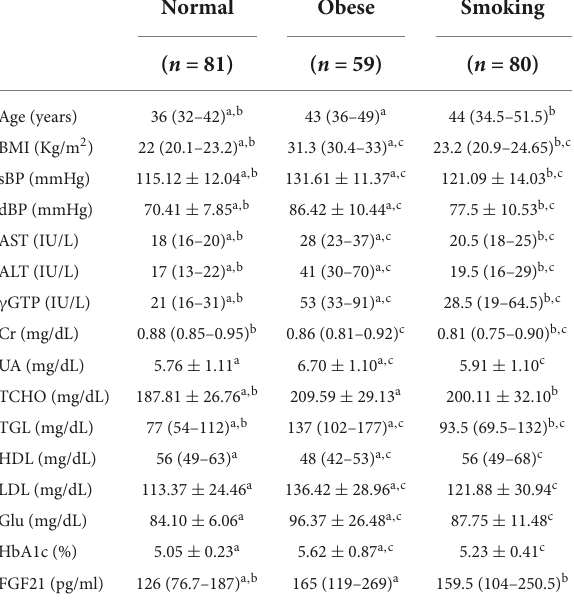
TABLE 2 Comparison of characteristics between normal, obese, and smoking groups.